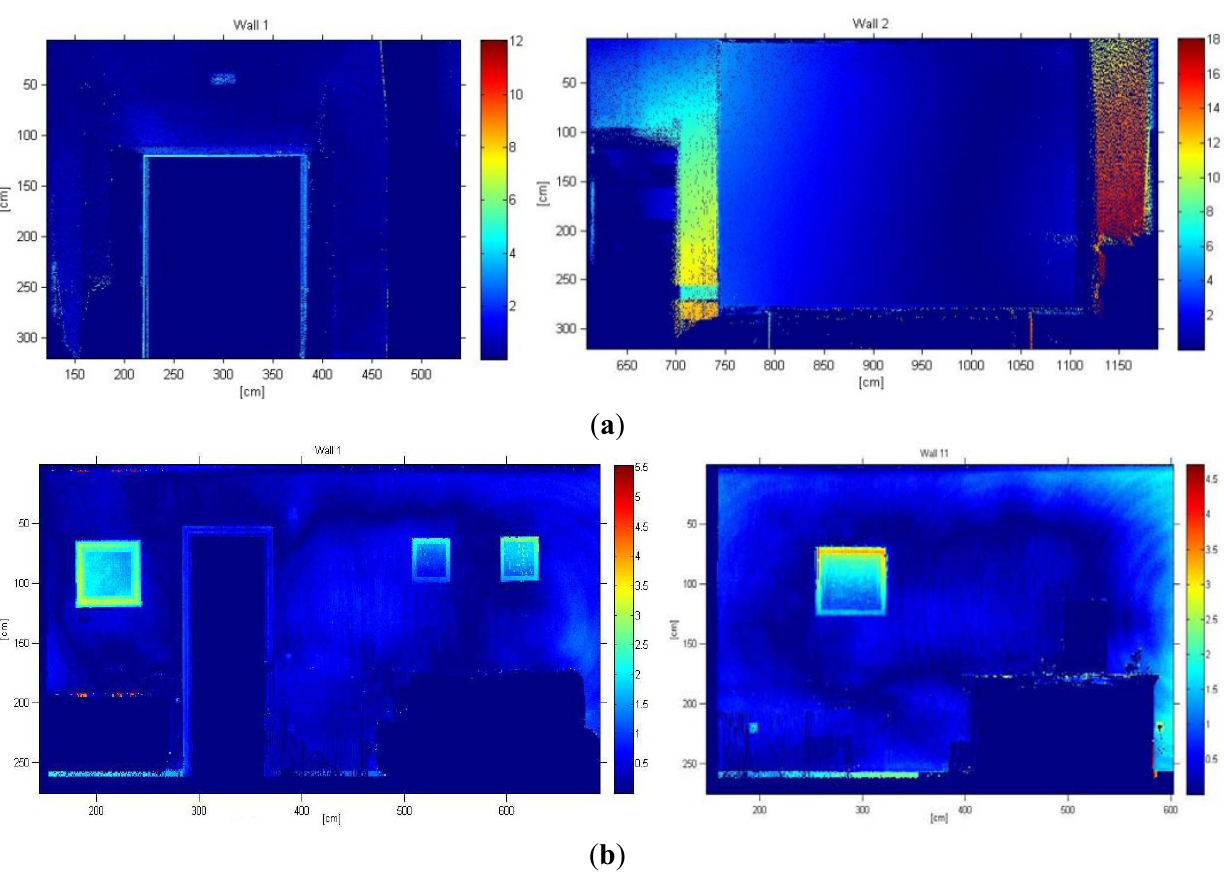
Figure 6. Deviation of the data to the fitted planes for two walls of the lab ( a ) and two walls of the living room. ( b ) Colorbars are coded in